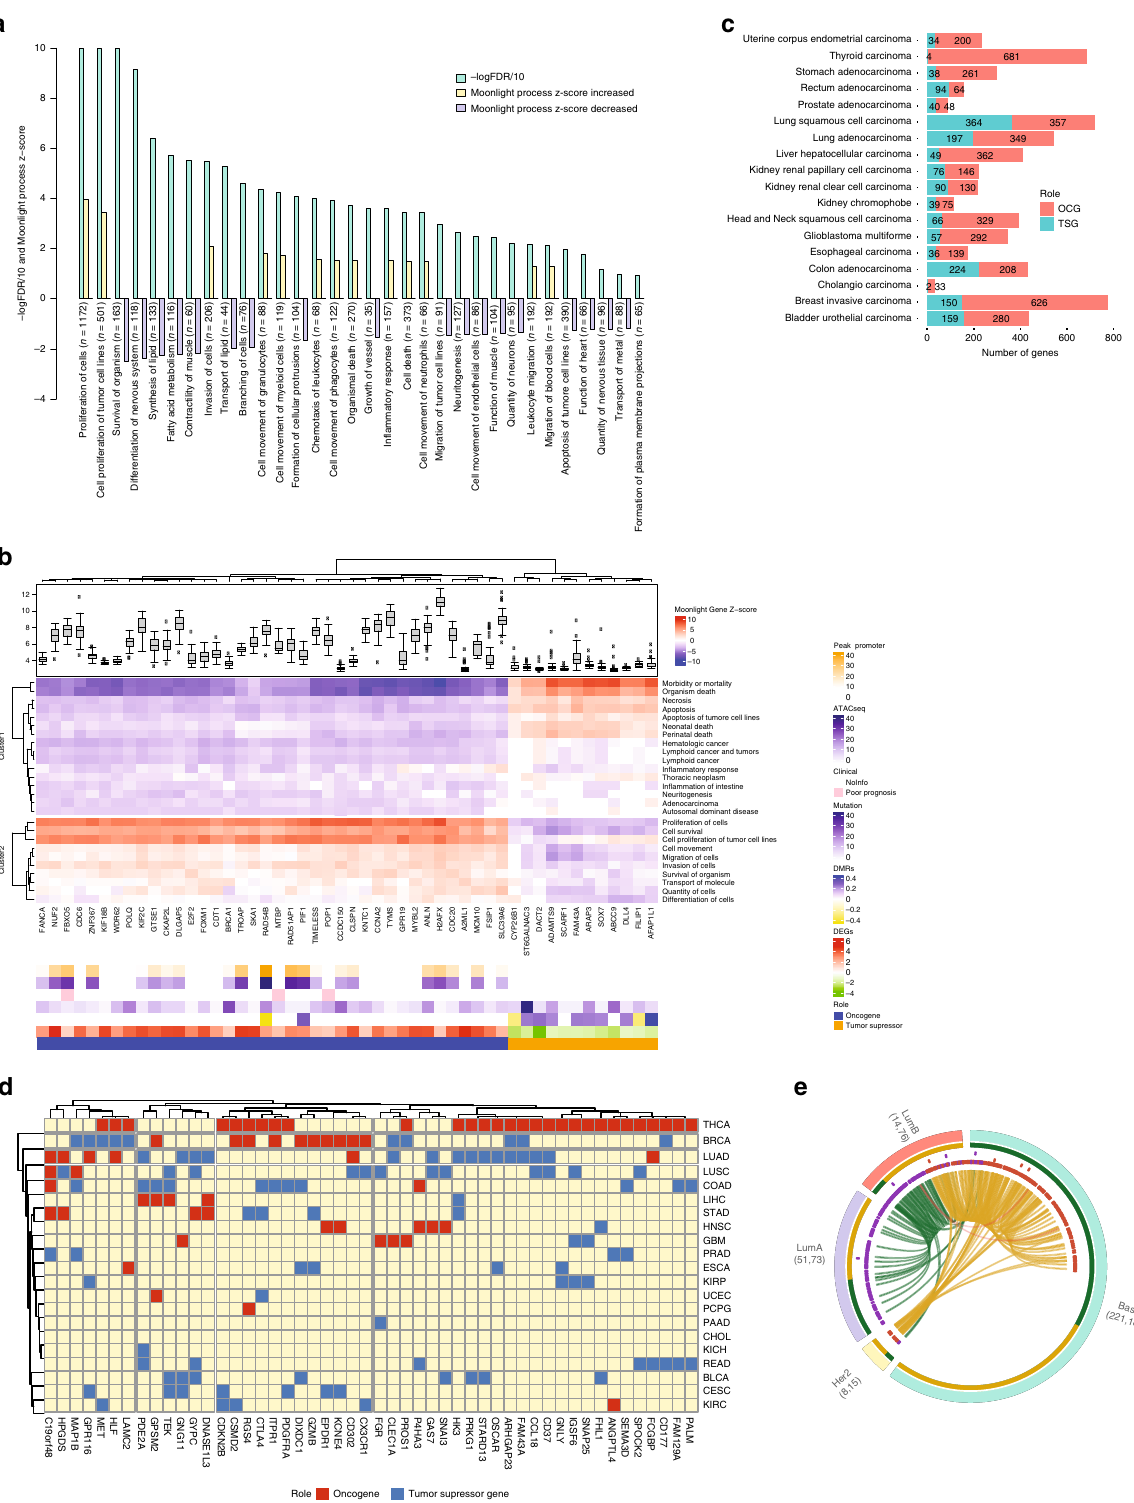
Apoptosis of tumore cell lines Neonatal death Perinatal death Hematologic cancer Lymphoid cancer and tumors Lymphoid cancer Inflammatory response Thoracic neoplasm Inflammation of intestine Neuritogenesis Adenocarcinoma Autosomal dominant disease Proliferation of cells Cell survival Cell proliferation of tumor cell lines Cell movement Migration of cells Invasion of cells Survival of organism Transport of molecule Quantity of cells Differentiation of